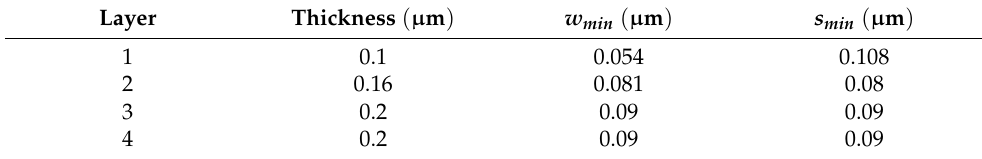
Table 2. Multilayer interconnect 55 nm process standard (first four metal layers) [11]. Layer